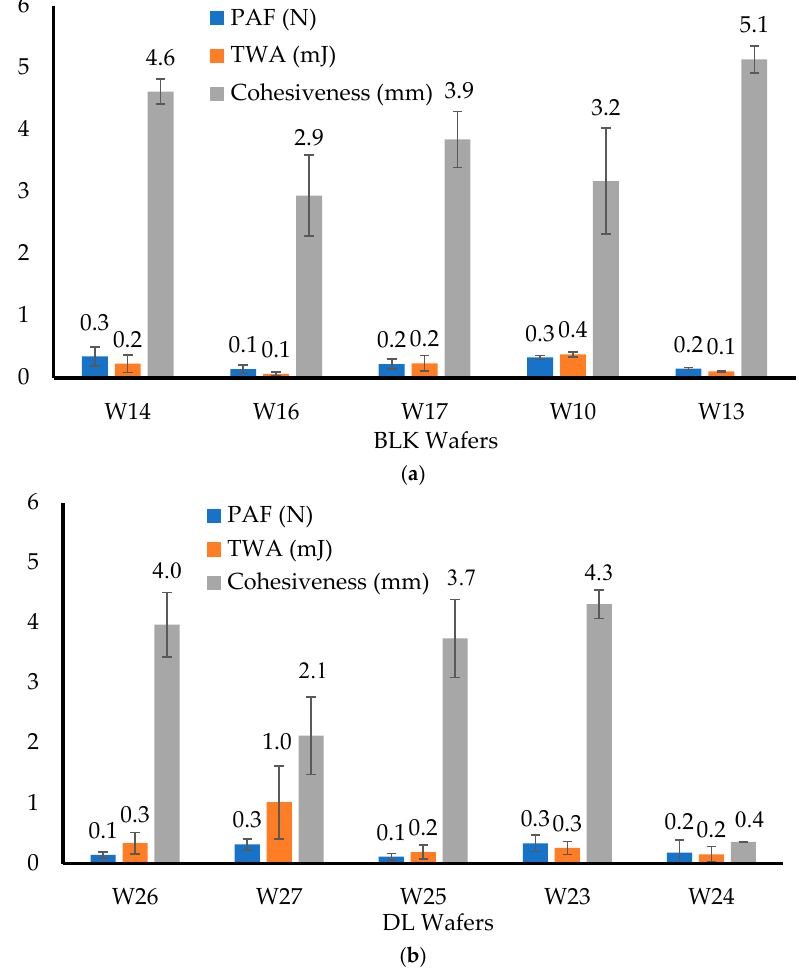
Figure 2. In vitro adhesive properties of BLK ( a ) and DL ( b ) wafers. Data labels on the histograms have been rounded to 1 decimal place. The W10 and W13 wafers showed a PAF of 0.33 ± 0.03 N and 0.18 ± 0.03 N, respec- tively. The TWA of the W10 and W13 wafers showed values of 0.38 ± 0.04 mJ and 0.1 ± 0.01 mJ, respectively, while the cohesiveness of the W10 and W13 wafers were 3.18 ± 0.86 mm and 5.1 ± 0.22 mm, respectively. W17 had a PAF value of 0.23 ± 0.08 N, a TWA of 0.24 ± 0.13 mJ, and a cohesiveness value of 3.85 ± 0.45 mm. This showed that with an increasing concentration of CARB, the cohesiveness decreased. The TWA values of the CARB:CARR wafers were higher than those of the CARB:SA wafers due to higher amounts of CARR in the formulations. This imparts adhesive properties due to the anionic structure of CARR, which helped the wafer to adhere more efficiently to the model mucosal surface. In addi- tion, anionic polymers that possess sulfate groups can bind to mucosal tissues better than those with carboxylic acid [27]. Therefore, CARR increased the mucoadhesive perfor- mance due to the negative charge of its sulfate group, which formed ionic bonds with the positively charged mucin present on the model mucosal surface [28]. The cohesiveness was also affected by the different CARB, CARR, and SA ratios, as well as by the total polymer content. The statistical analysis showed that there was a significant difference